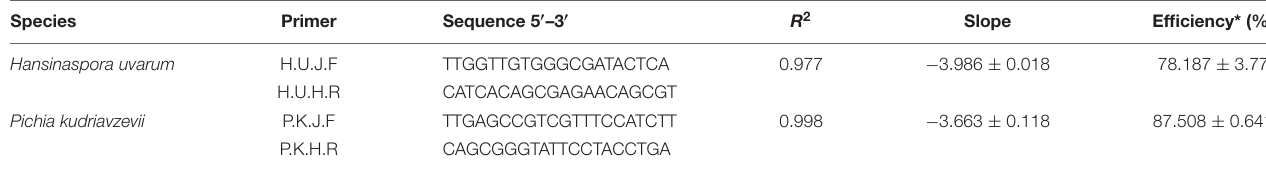
TABLE 1 | Correlation coefficient, slope, and efficiency of standard curves estimated from serial dilution of the target yeasts grown in YE broth. Species Primer Sequence 5 (cid:48) –3 (cid:48) R 2